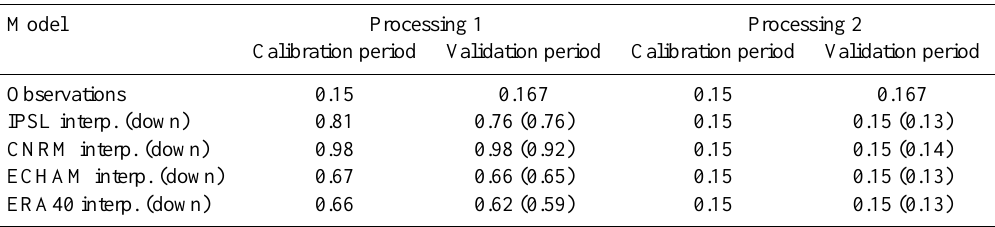
Table 2. Occurrence of precipitating events for each model and over the calibration period 1981–1990 (columns 2 and 4), and the vali- dation period 1991–2000. Columns 2 and 3, and 4 and 5 correspond to processing 1 (non-zero precipitation) and processing 2 (threshold precipitation), respectively. The values between brackets correspond to those produced by